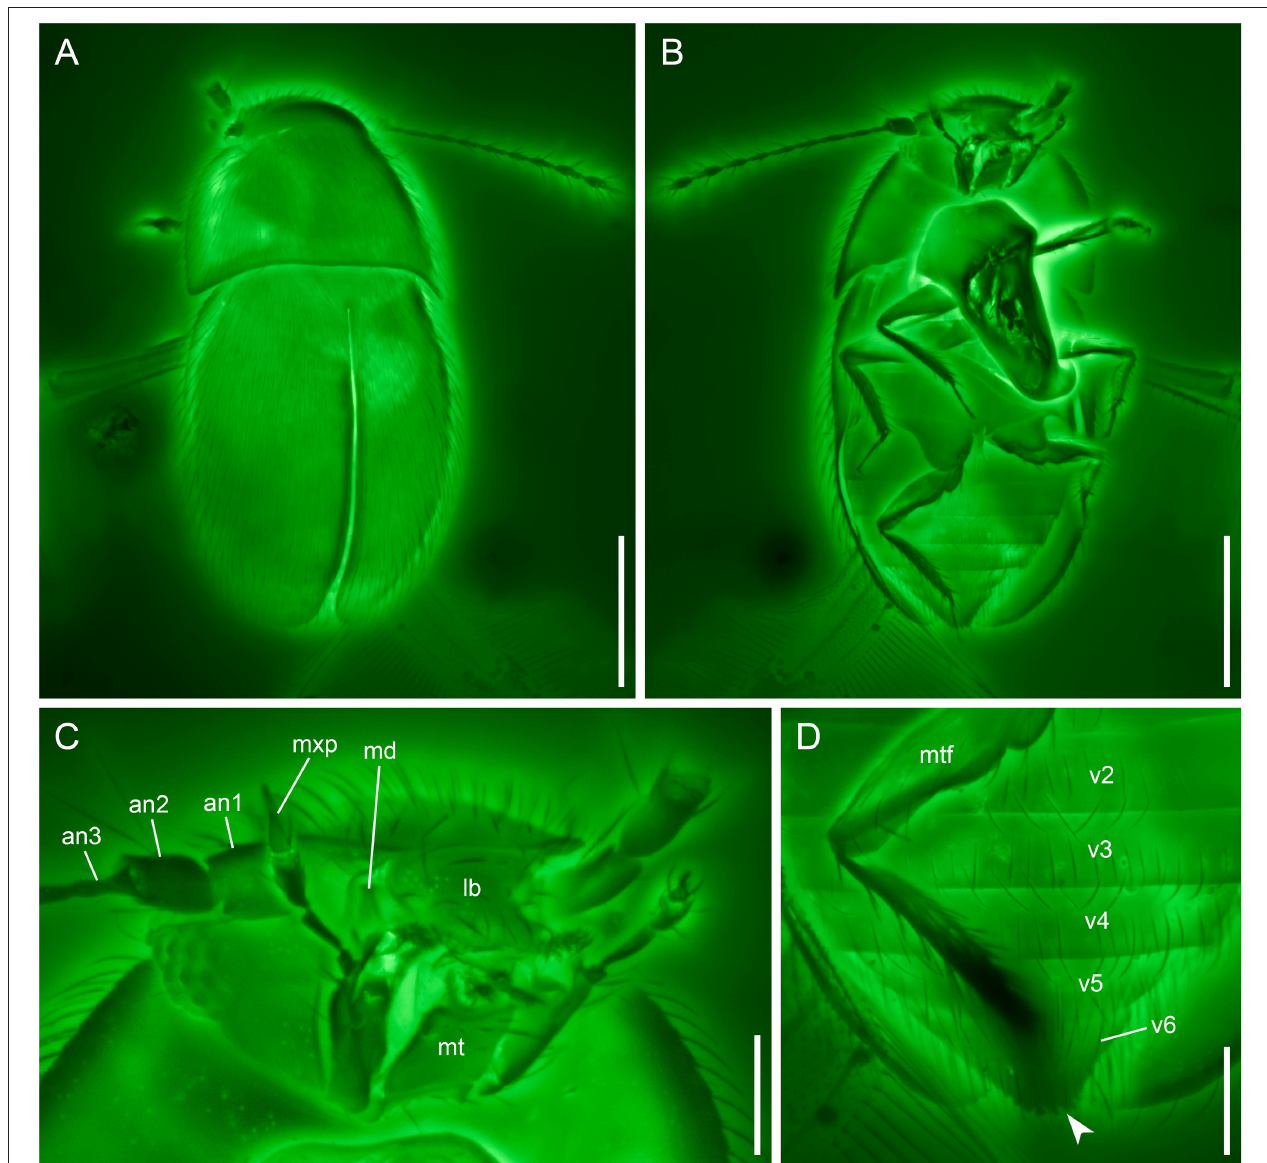
FIGURE 3 | Crenossidium slipinskii Li, Newton and Cai gen. et sp. nov. , holotype, NIGP180053, under confocal microscopy. (A) Habitus, dorsal view. (B) Habitus, ventral view. (C) Mouthparts, ventral view. (D) Abdomen, ventral view, showing the multidentate pygidium (arrowhead). an1–3, antennomeres 1–3; lb, labrum; md, mandible; mt, mentum; mtf, metafemur; mxp, maxillary palp; v1–6, ventrites 1–6. Scale bars: 200 µ m in (A,B) , 50 µ m in (C,D) .